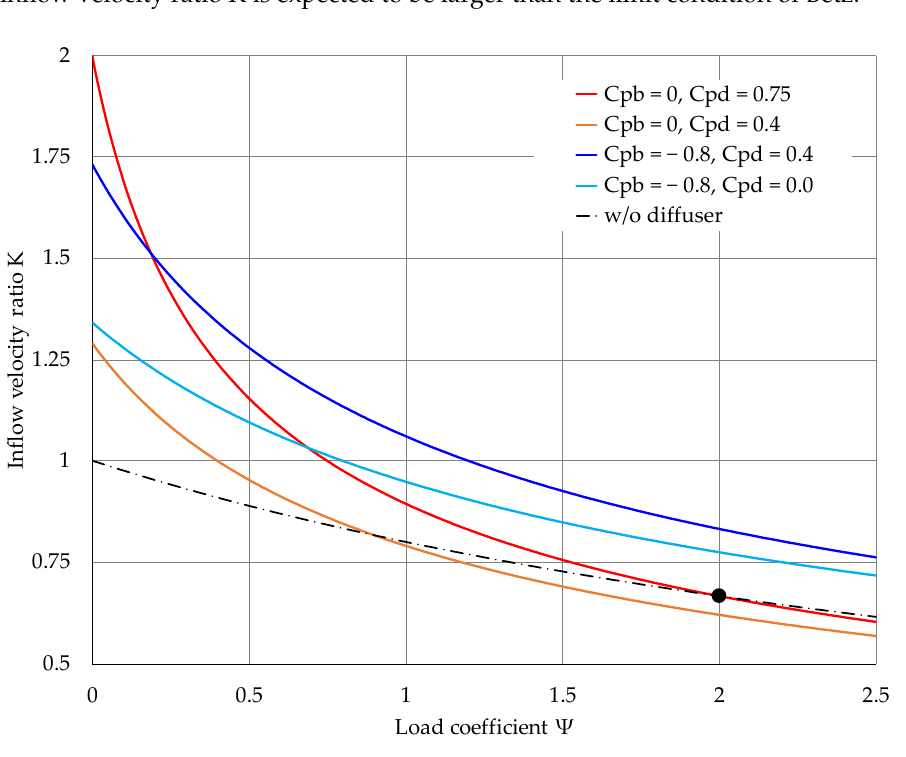
Figure 6. Variation of inlet velocity ratio K with loading coefficient.